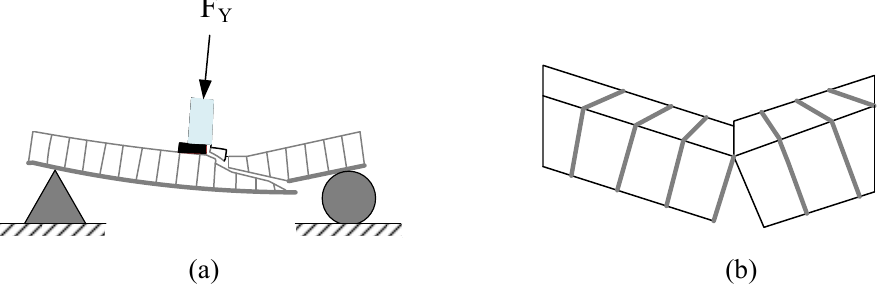
Figure 20. The FMs of single-layer specimens: ( a ) the position of failure, textile rupture, between two bricks or joints (mortar) the below the load points; ( b ) failure mode in the wall: shear failure.